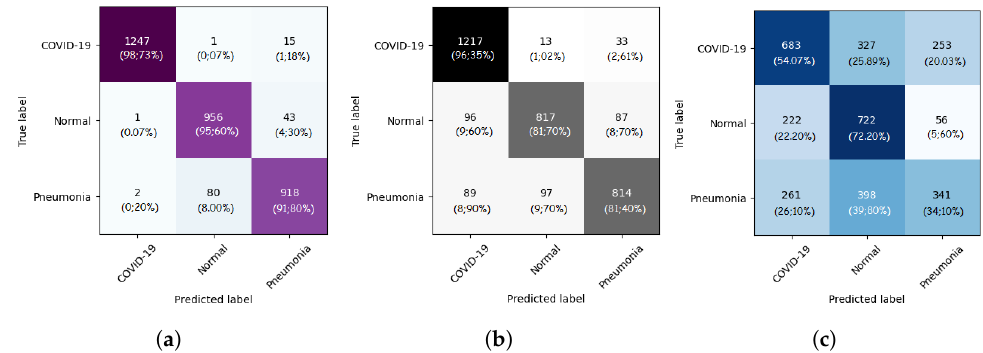
Figure 4. Confusion matrices of ViT-B16 ( a ), ViT-B32 ( b ), and ViT-L32 ( c ) (COVID-19 vs. Pneumonia vs. Normal) classification.